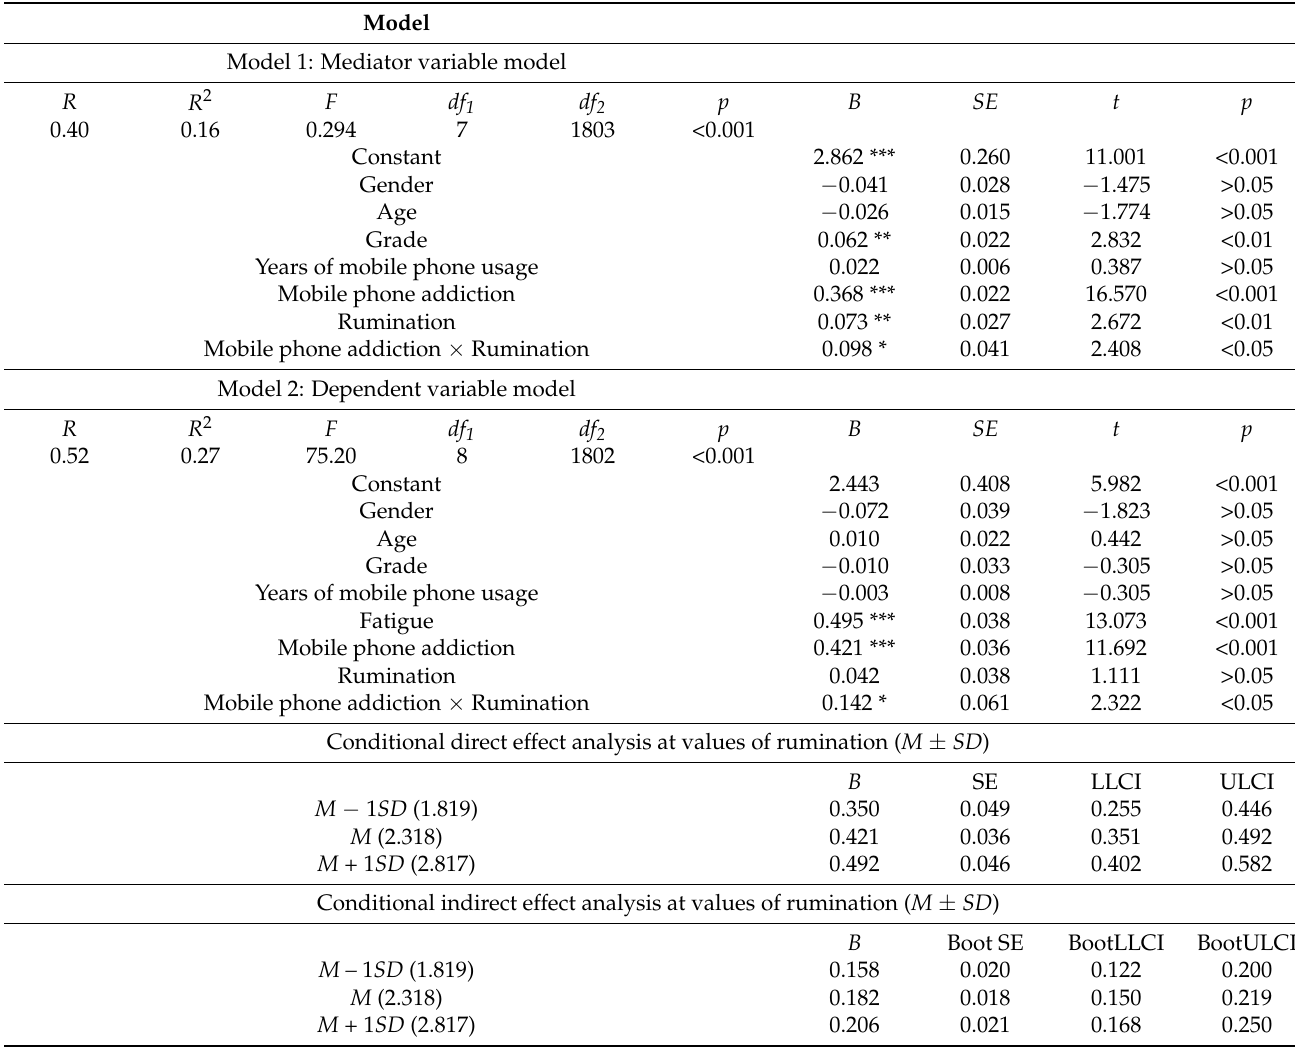
Table 3. Regression results for the conditional indirect effects (moderated